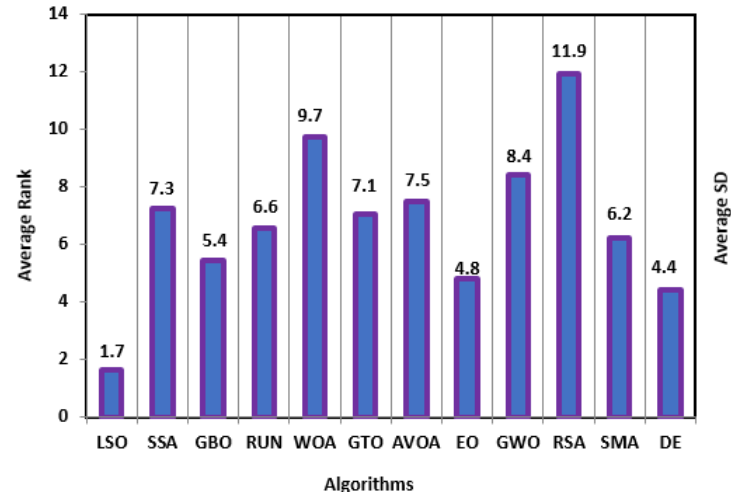
Figure 9. Average rank of each optimizer on all CEC2014.